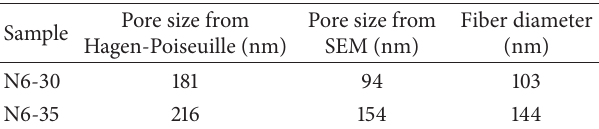
Table 2: The pore sizes from Hagen-Poiseuille equation and from SEM